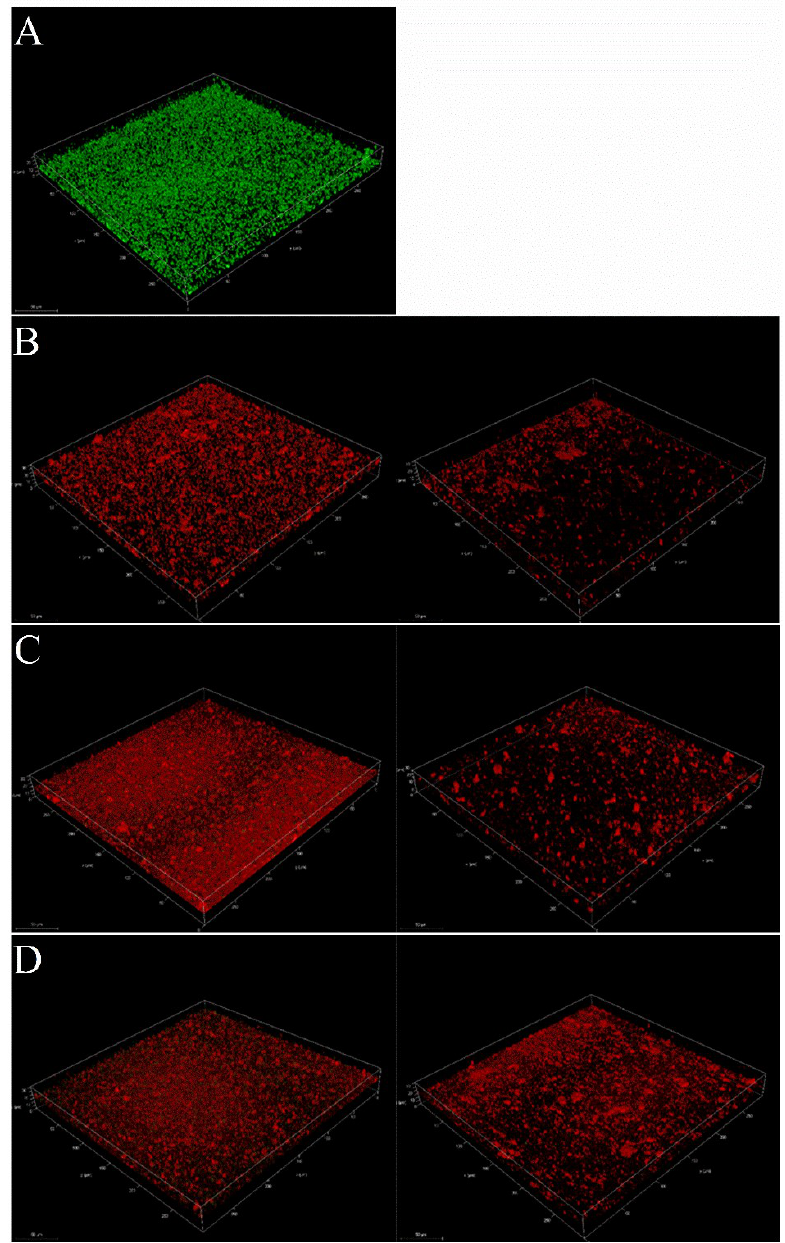
Figure 6. Confocal Laser Scanning Microscopic 3D images of Staphylococcus aureus biofilms. ( A ) negative control. ( B ) sub-MIC concentrations of pseudopyronine A. Left-2 × MIC; Right-8 × MIC. ( C ) sub-MIC concentrations of pseudopyronine B. Left-2 × MIC; Right-8 × MIC. ( D ) sub-MIC concen- trations of pseudopyronine C. Left-2 × MIC; Right-8 × MIC. Green and red fluorescence represent live and dead cells,